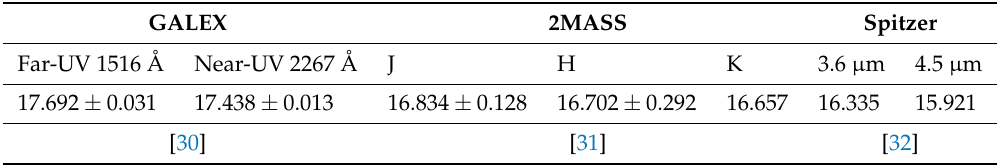
Table 4. Stellar magnitudes of GR290 in ultraviolet and infrared